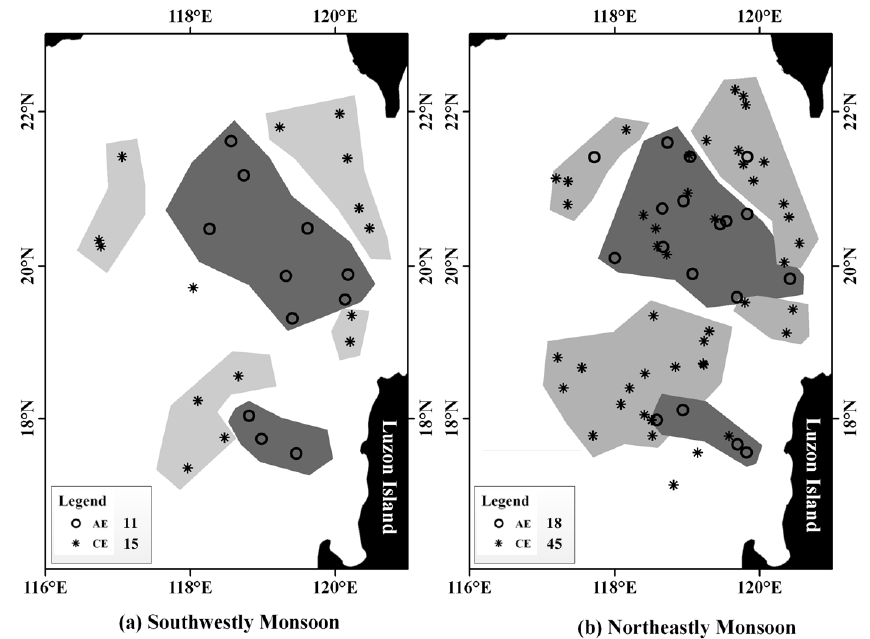
Fig. 8. Eddies of A1 and C1 generated in northeastern SCS during different monsoon seasons. Concentration regions of AEs and CEs are represented by different